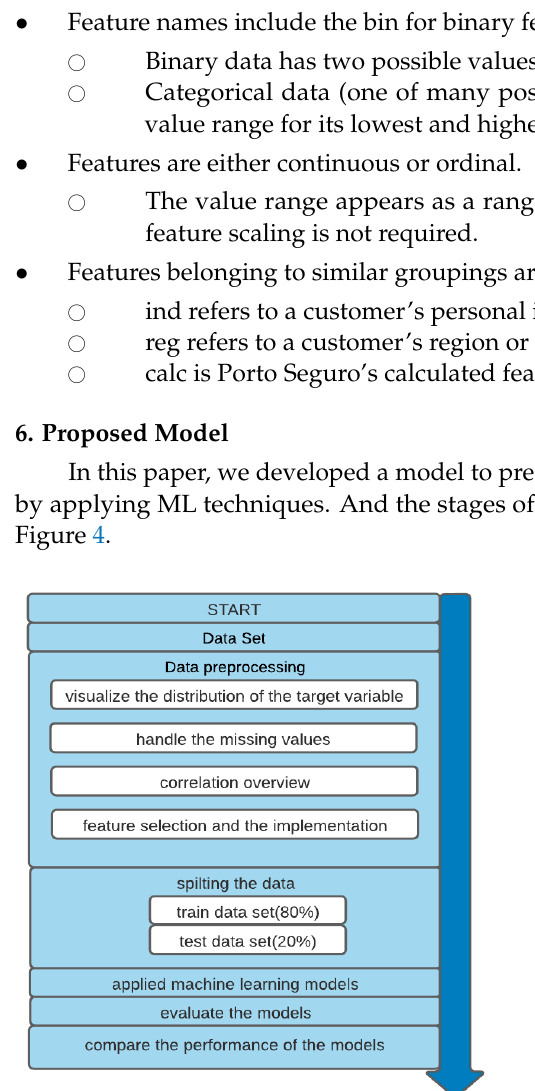
Figure 5. Histogram of the distribution of target values.